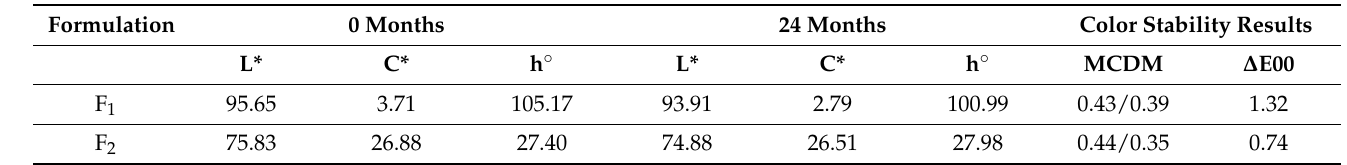
Table 4. Results of color stability (MCDM, ∆ E00) at 0 and 24 months for two different formulations, F 1 and F